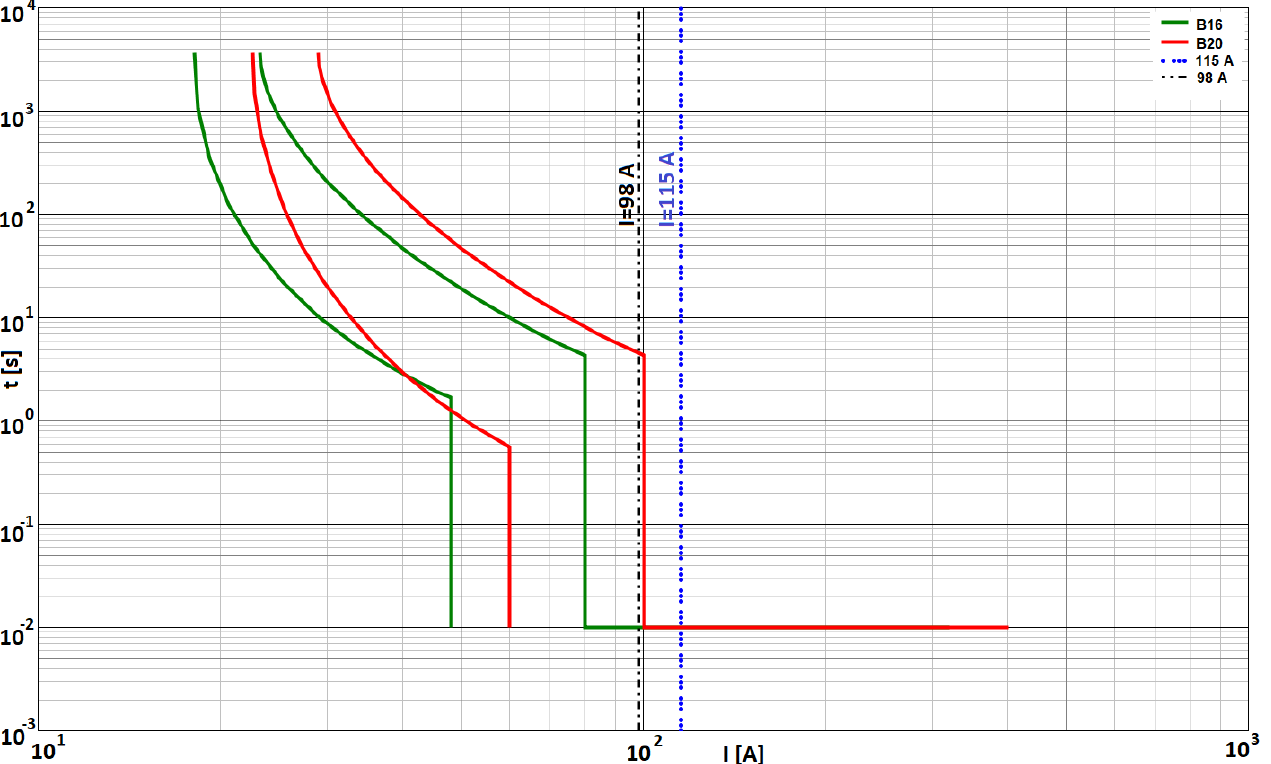
Figure 9. B16 and B20 curves with expected short-circuit currents with or without the proposed breaker.